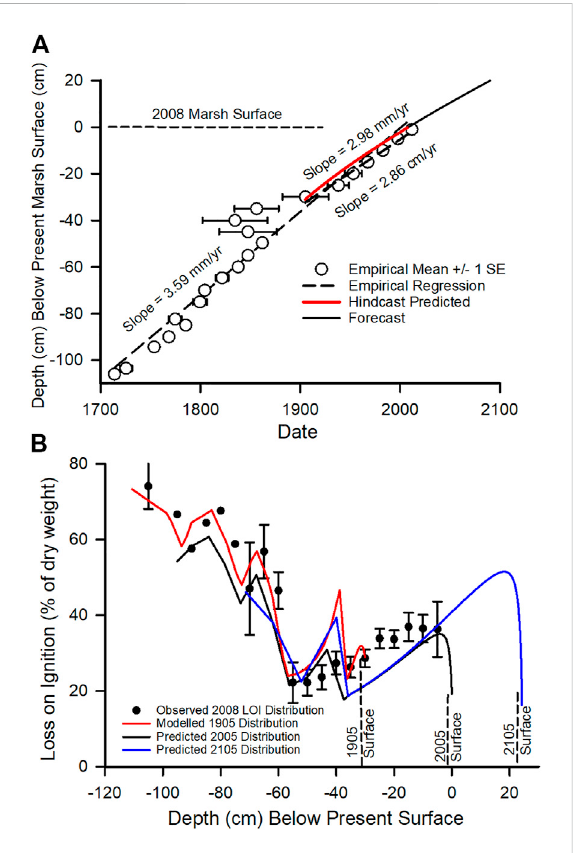
FIGURE 3 (A) Observed depths (un fi lled circles) of dated core sections grouped into 5-cm depth bins (mean ± 1 SE) with hindcasted (red line) and forecasted (black line) depths versus date. (B) Depth distributions of loss on ignition (LOI) values at the start of the hindcast (1905), at present (2005) and 100 years into the future. Note: the ground surface of the 1905 pro fi le, which is the start of thehindcast,wasabout30 cmbelowthecurrentsurfaceasshown in (A) . The simulations assumed a constant SLR of 2